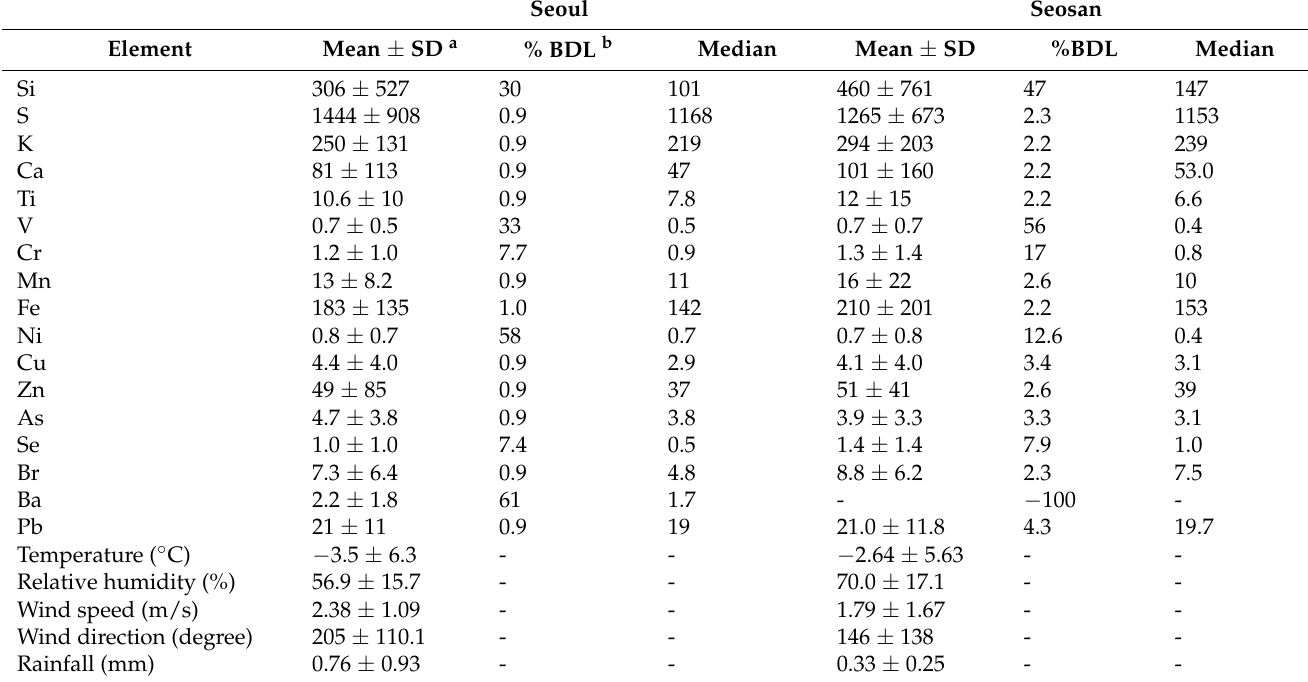
Table 1. Summary statistics of trace element concentrations (ng m − 3 ) in PM 2.5 quantified in